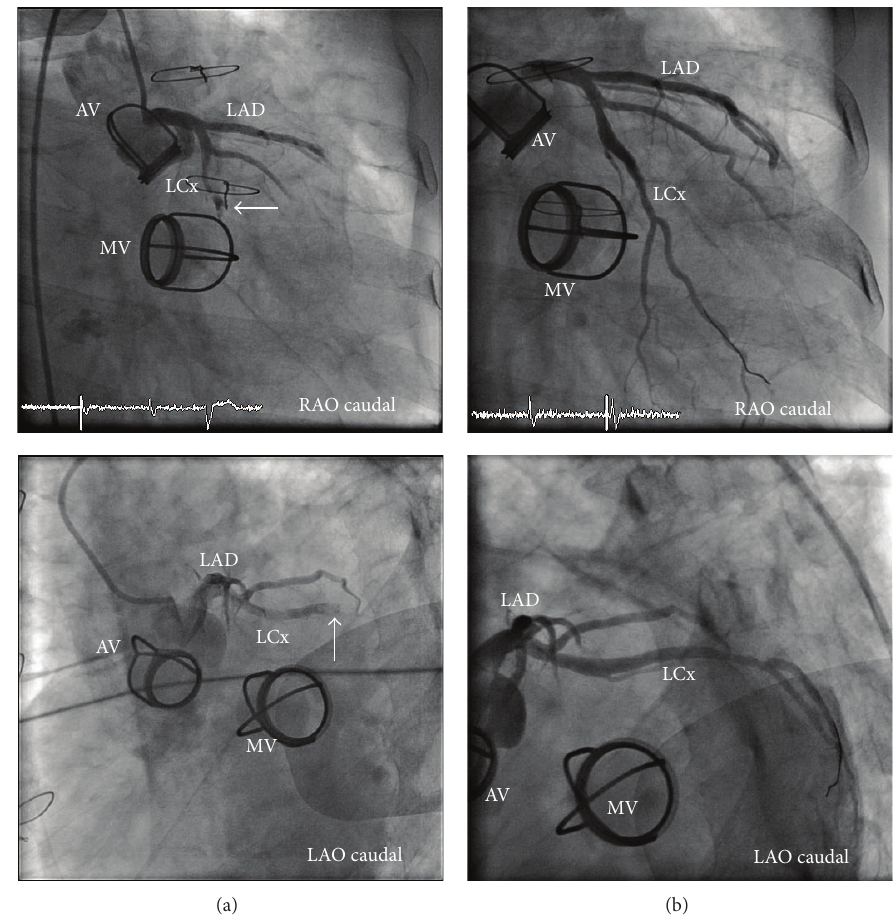
Figure3:Angiogramofleftcoronaryarterydemonstratingfillingdefect(whitearrow)atthemidportionofLCx(a).Afterthrombectomywith elimination aspiration catheter, blood flow in LCx was completely restored. The underlying vessel lumen appeared to be normal (b). ∗ LAD- left anterior descending artery, LCX-left circumflex artery, LAO-left anterior oblique, RAO-right anterior oblique, AV-aortic prosthetic valve, and MV-mitral prosthetic